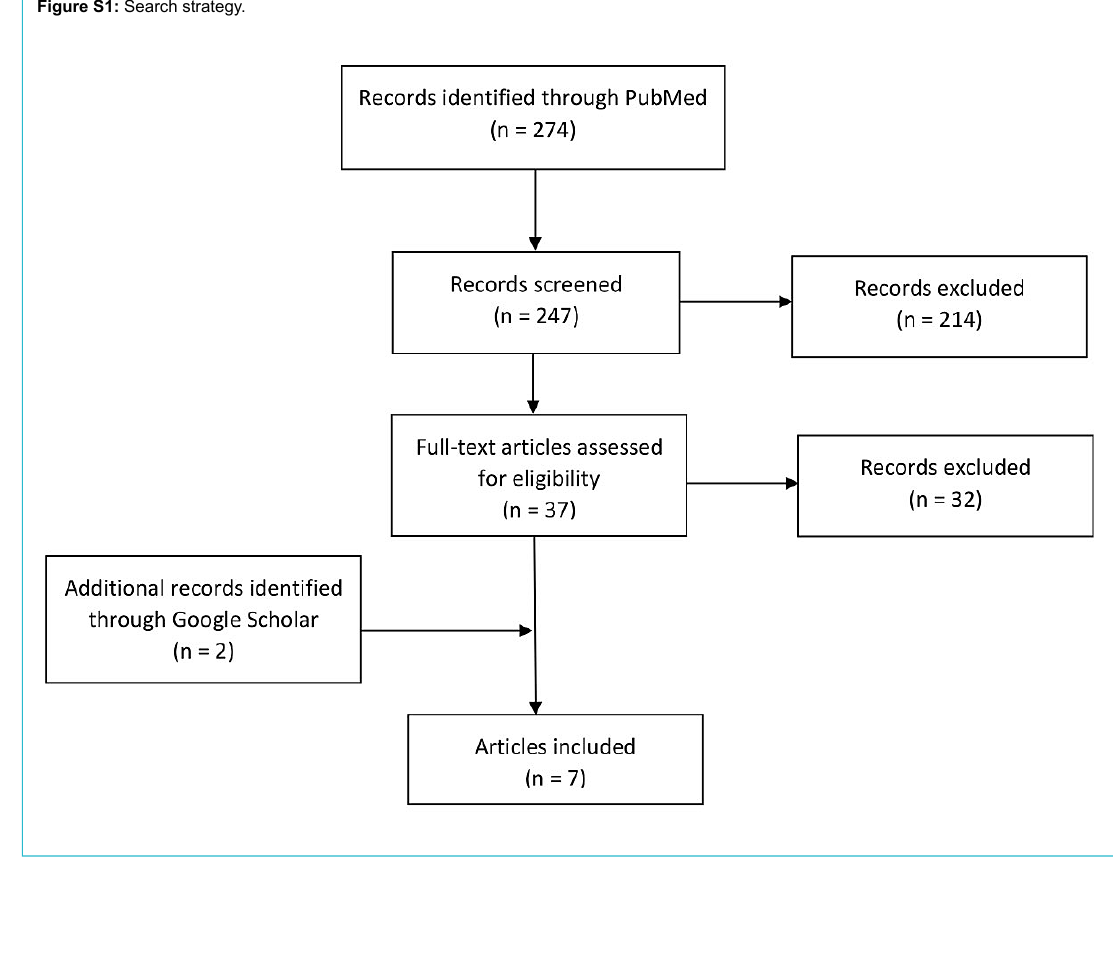
Figure S1: Search